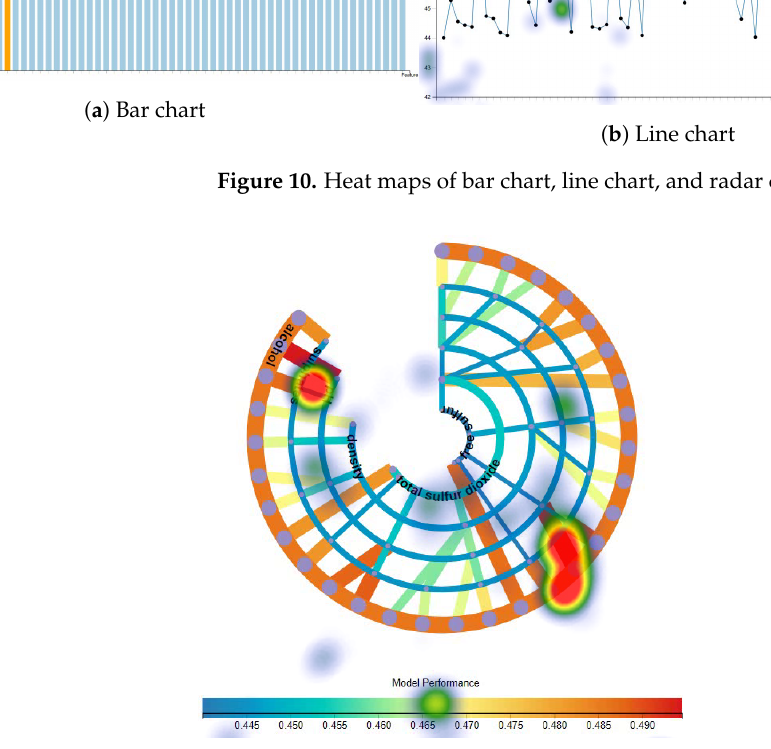
Figure 11. Heat map of